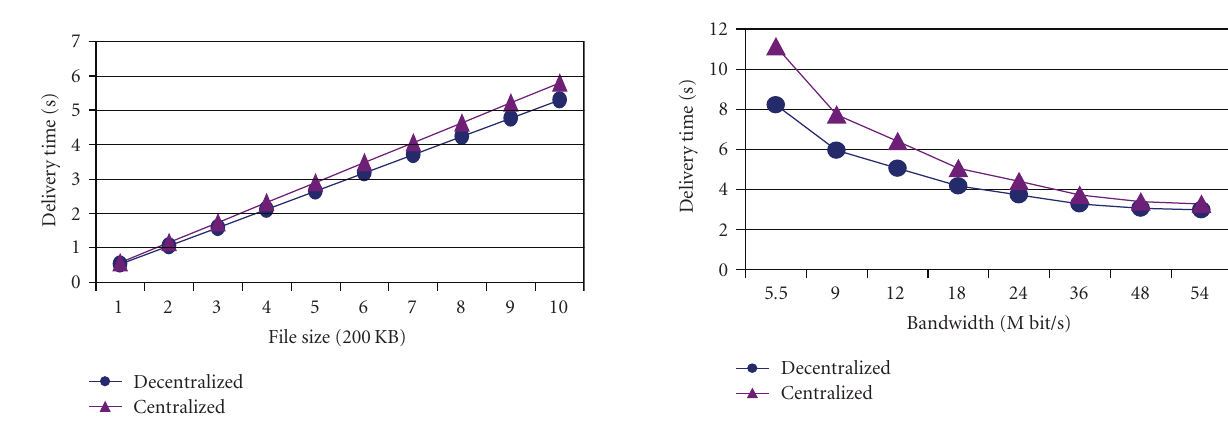
Figure 11: Delivery time versus bandwidth. (File size = 1 Mbyte, three services are